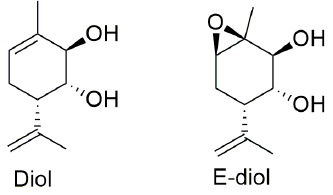
Figure 1. Structures of Diol and E-diol.